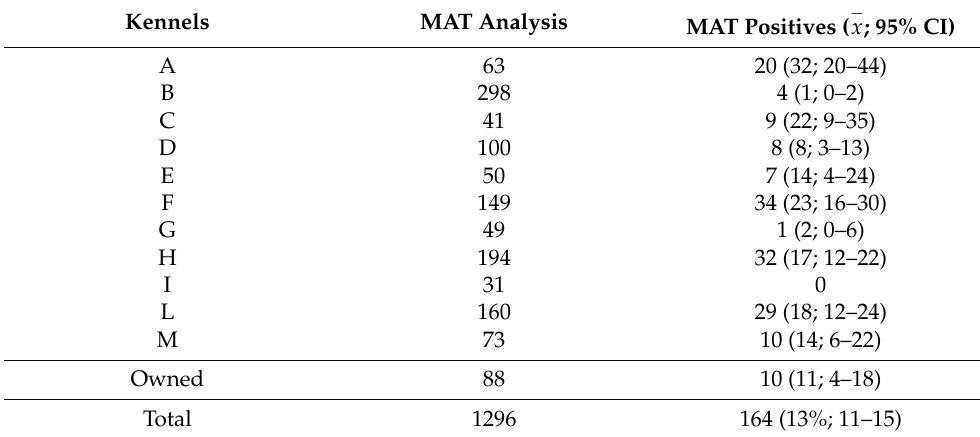
Table 3. Summary of MAT-positive dogs analyzed in this study.